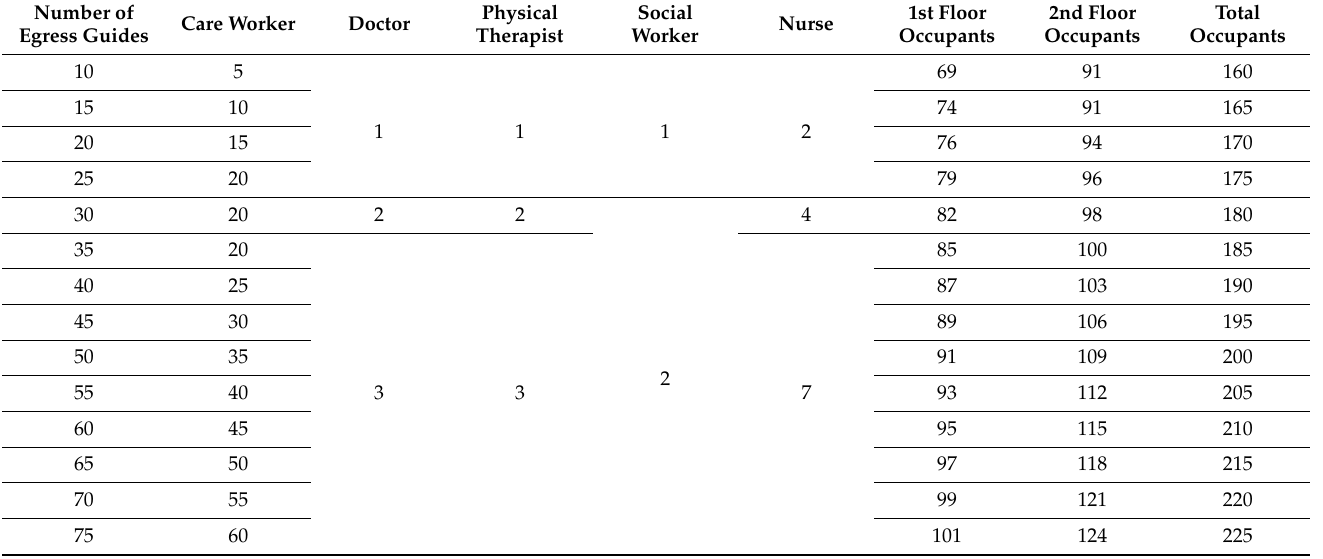
Table 3. Number of workers (egress